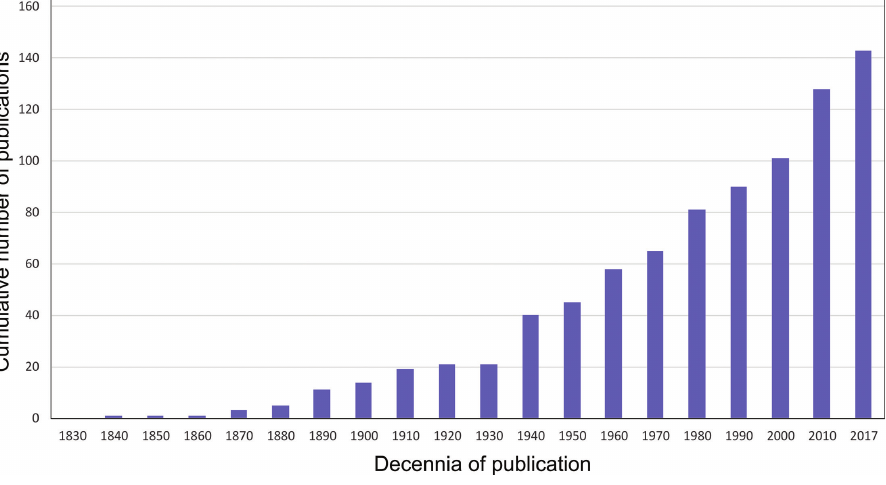
Figure 2. Cumulative number of publications on Belgian woodlice from 1831 until